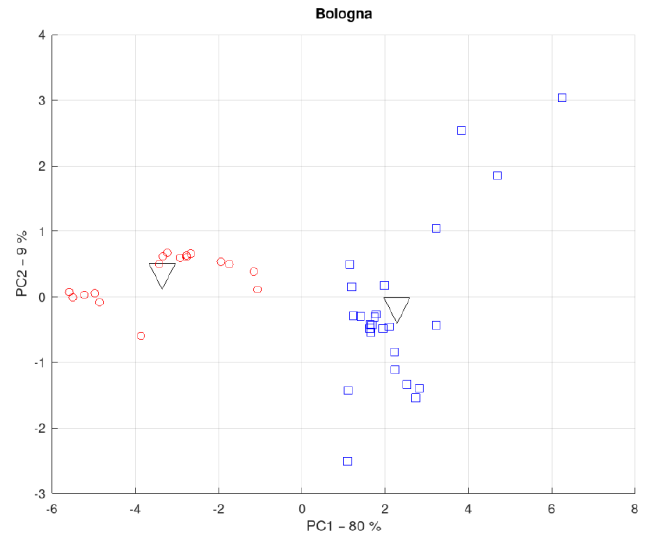
Figure 2. District of the metropolitan city of Bologna 2D-Score plot showing PC1 vs. PC2 with clusters highlighted: first cluster in red and the second cluster in blue.